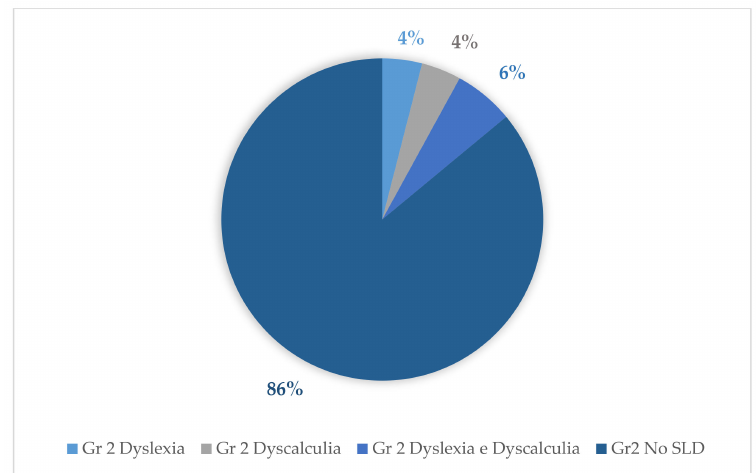
Figure 4. Percentages of SLD (specific learning disabilities) in group 1.